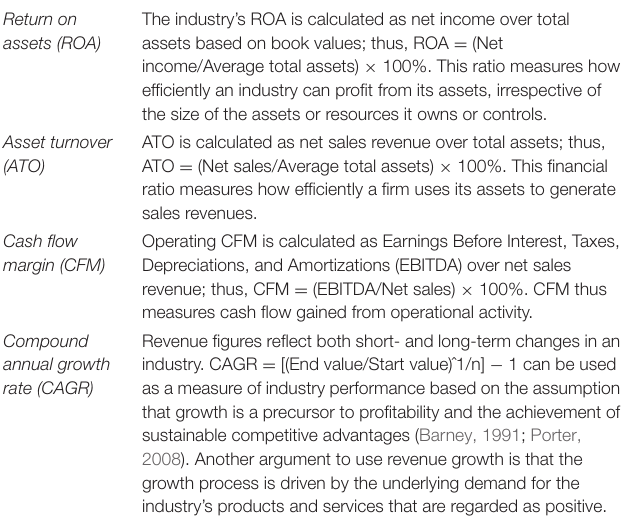
TABLE 2 | Performance measures applied in this